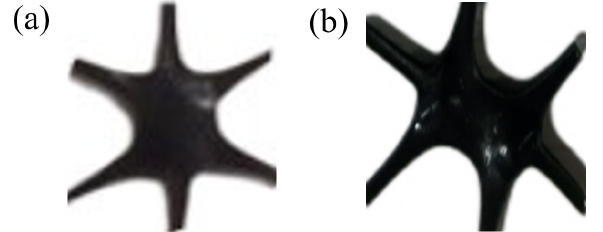
Figure 6. Nodes of different shapes. ( a ) Convex nodes in the middle, ( b ) concave nodes in the middle.